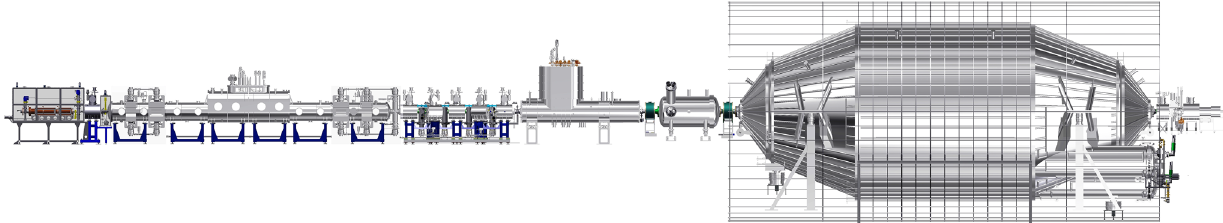
Fig. 1 Experimental setup of the KATRIN experiment. The main components are (from left to right): calibration and monitoring rear section, windowless gaseous tritium source, transport section, pre-spectrometer, main spectrometer and focal plane